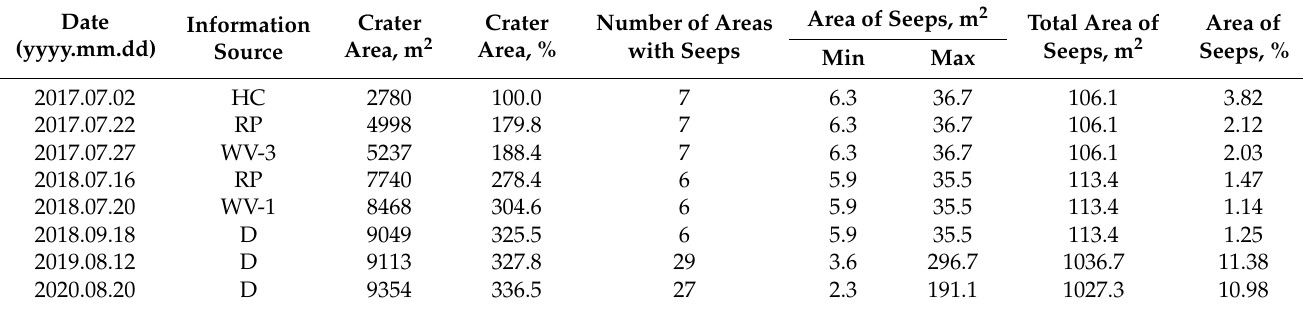
Table 1. Generalized characteristics of the C11 crater dimensions, the number and size of the gas emission areas (locations of seeps are shown in Figure 5).